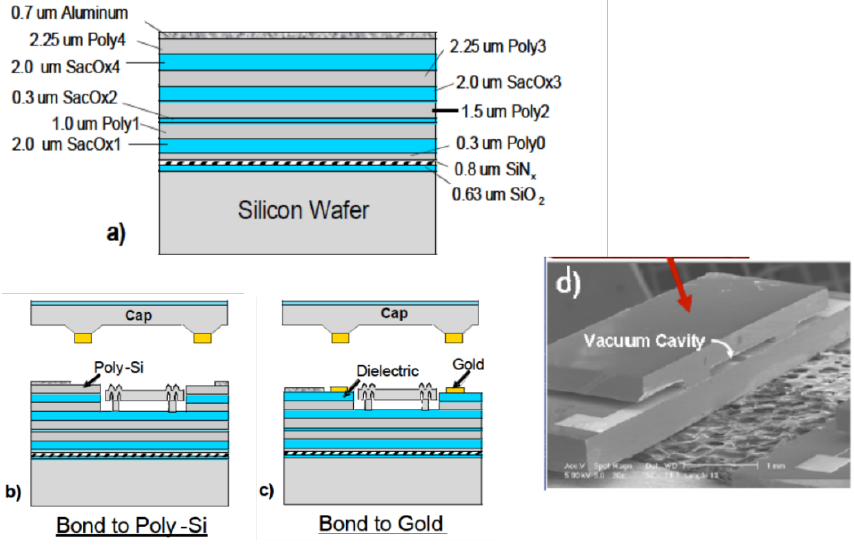
Figure 5. A wafer-level vacuum packaging (WLVP) approach in which Au 0.82 Si 0.18 eutectic is formed on the cap wafer and bonded to a wafer containing complementary metal-oxide semiconductor (CMOS) elements and a Pirani vacuum sensor. ( a ) SUMMiT V TM thin film CMOS process; ( b ) Bond directly to poly-Si layer on CMOS wafer; ( c ) Bond to Au layer on CMOS wafer; ( d ) Scanning electron microscope (SEM) image of a successfully packaged sensor. [56] Reprinted with permission from Dr. Jay Mitchell.